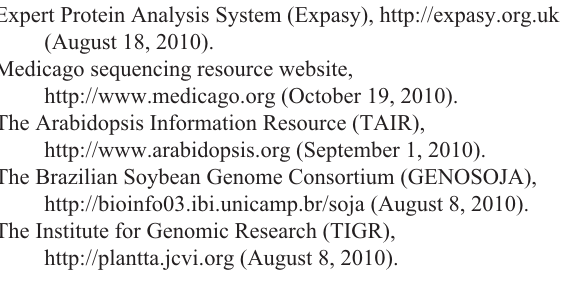
Figure S1 - Xa21 expression profile in 16 different li- braries from GENOSOJA. Figure S2 - PR-2 expression profile in 16 different li- braries from GENOSOJA. Table S1 - Accession number of reference PR genes used as seed sequences. Table S2 - Number of SuperSAGE tags per compari- son. Table S3 - SuperSAGE tags that matched genes. Table S4 - Number of tag repetitions in comparisons matching R and PR